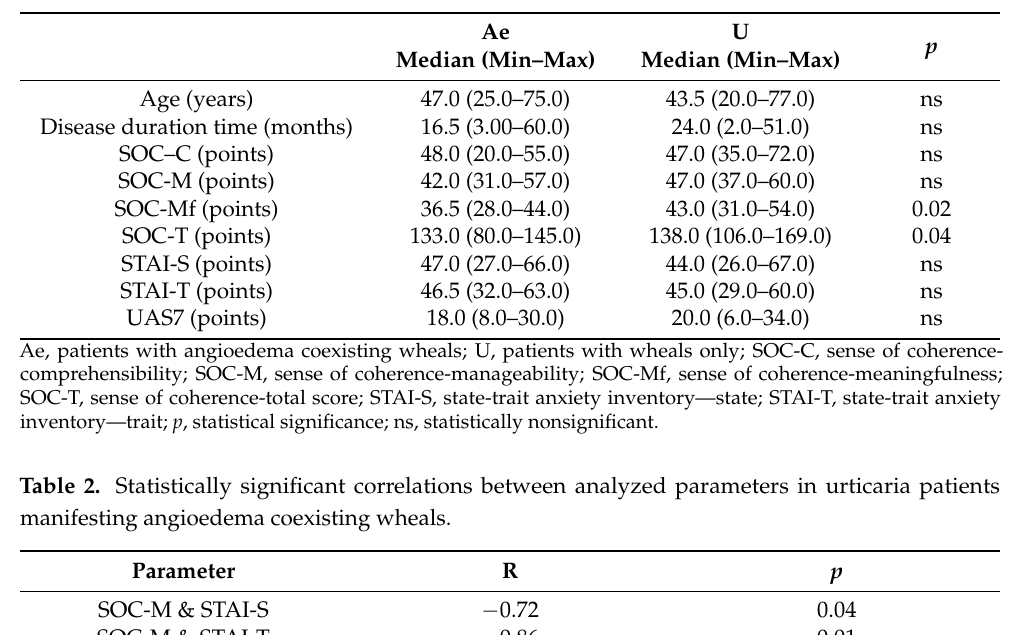
Table 1. Comparison of analyzed parameters between studied groups of urticaria patients.